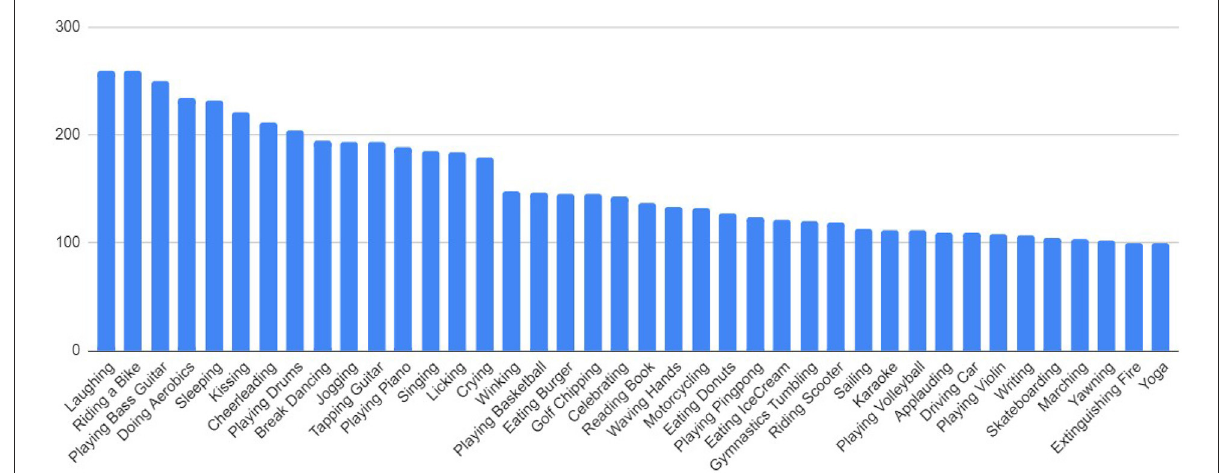
FIGURE3 The 40 most frequent classes after filtration of the Ani-GIFs dataset. Classes that have the highest frequency belong to actions with a large number of associated GIFs, e.g., common actions and emotions. We choose these forty classes as a subset for GIFs domain adaptation.